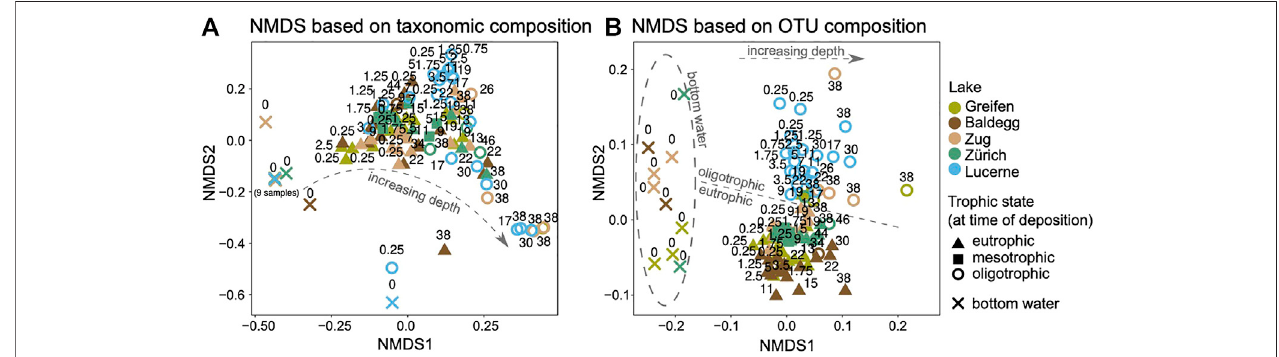
FIGURE 6 | Non-linear multi-dimensional scaling (NMDS) ordination of sediment and water samples based on (A) taxonomic groups shown in Figure 5 , and (B) OTUs (only general A1809/Mb66a pmo A primer pair). Sediment depths of key samples (in cm) are written into both panels. The low OTU diversity (19 OTUs in total, mainly Lake Lucerne) did not allow for an NMDS analysis of NC10 pmo A sequences.